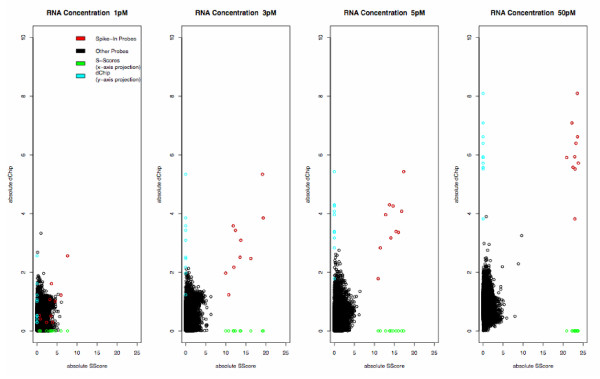
Comparison of S-Score and dChip. Plot of absolute value of S-Score vs absolute value of difference in base 2 logarithm of dChip model-based expression index, comparing the specified concentration to the baseline chip. X- and Y-axis projections are added to show separation of spike-in probes more clearly.